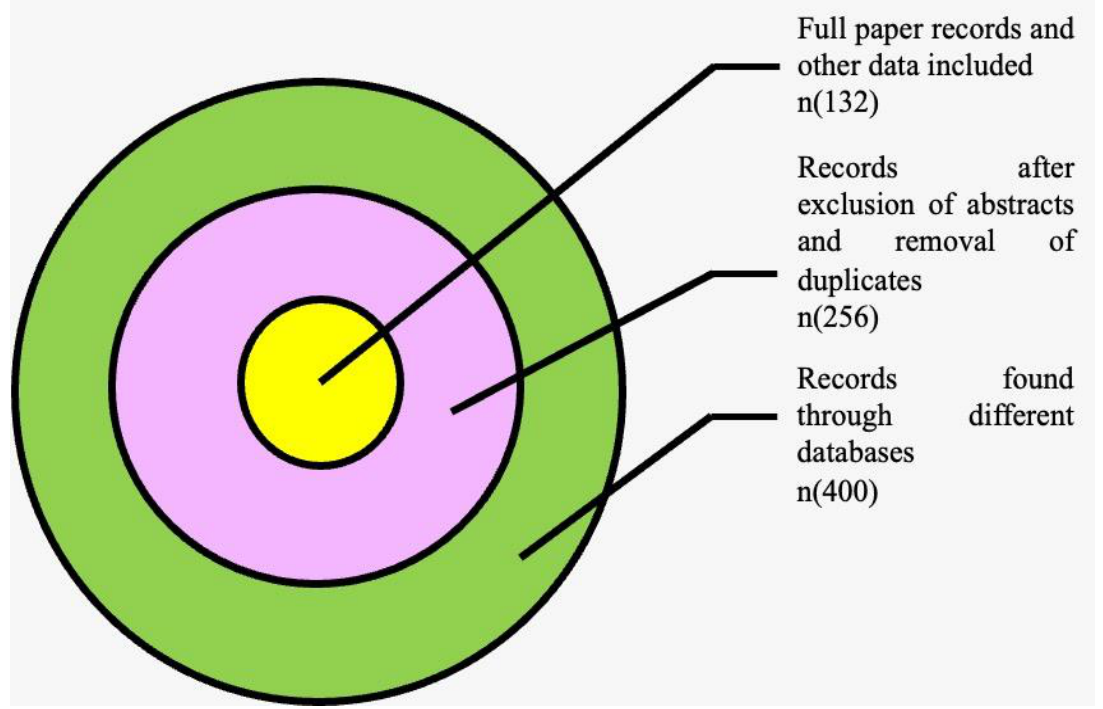
Figure 1. Venn diagram depicting search strategy.